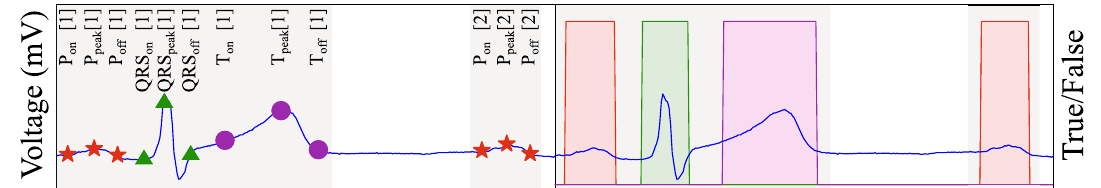
Figure 1. Database’s high-quality ground truth as fiducials (left) and as three overlapped binary masks (right). Red mask/stars: P wave. Green mask/triangles: QRS wave. Magenta mask/circles: T wave. The figure depicts the employed